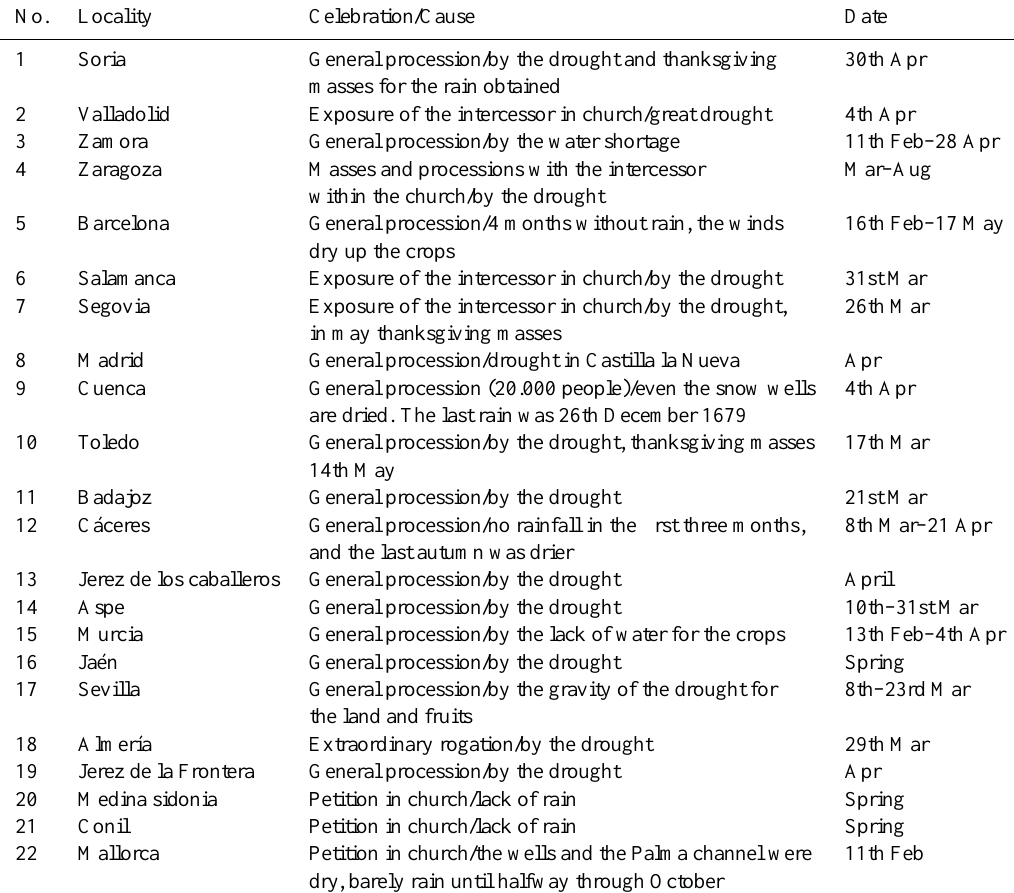
Table 2. Sites with a drought documentarily registered in spring 1680, location, date and detail about the information